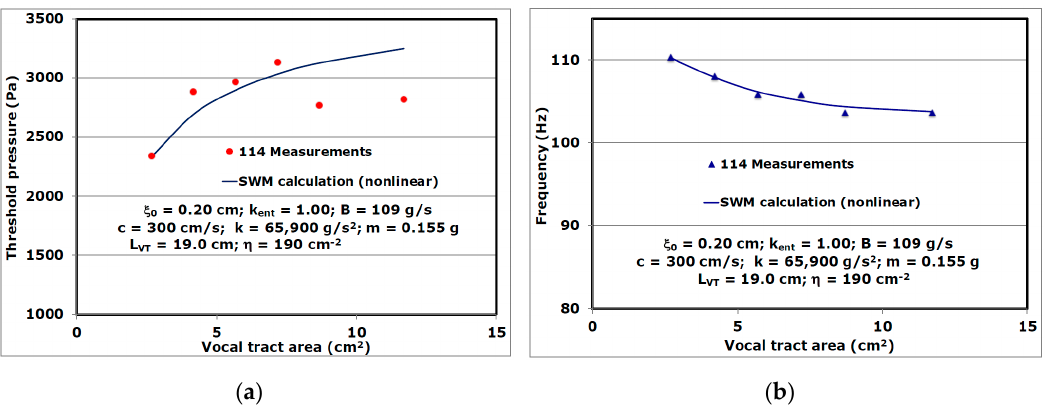
Figure 10. (Color online) ( a ) Measured and calculated threshold pressures for vocal tracts with different areas for vocal fold model 114. ( b ) Measured and calculated frequencies for vocal tracts with different areas for vocal fold model 114.